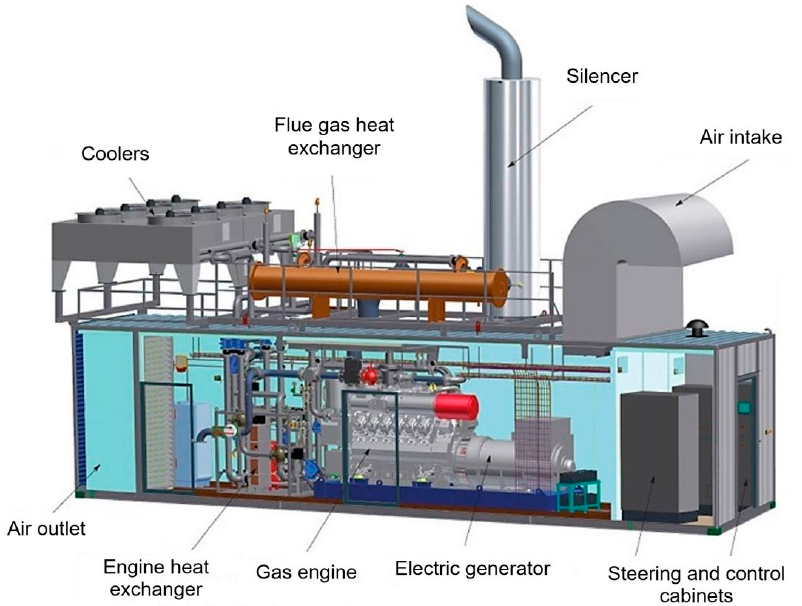
Figure 1. General view of the cogeneration unit [34].